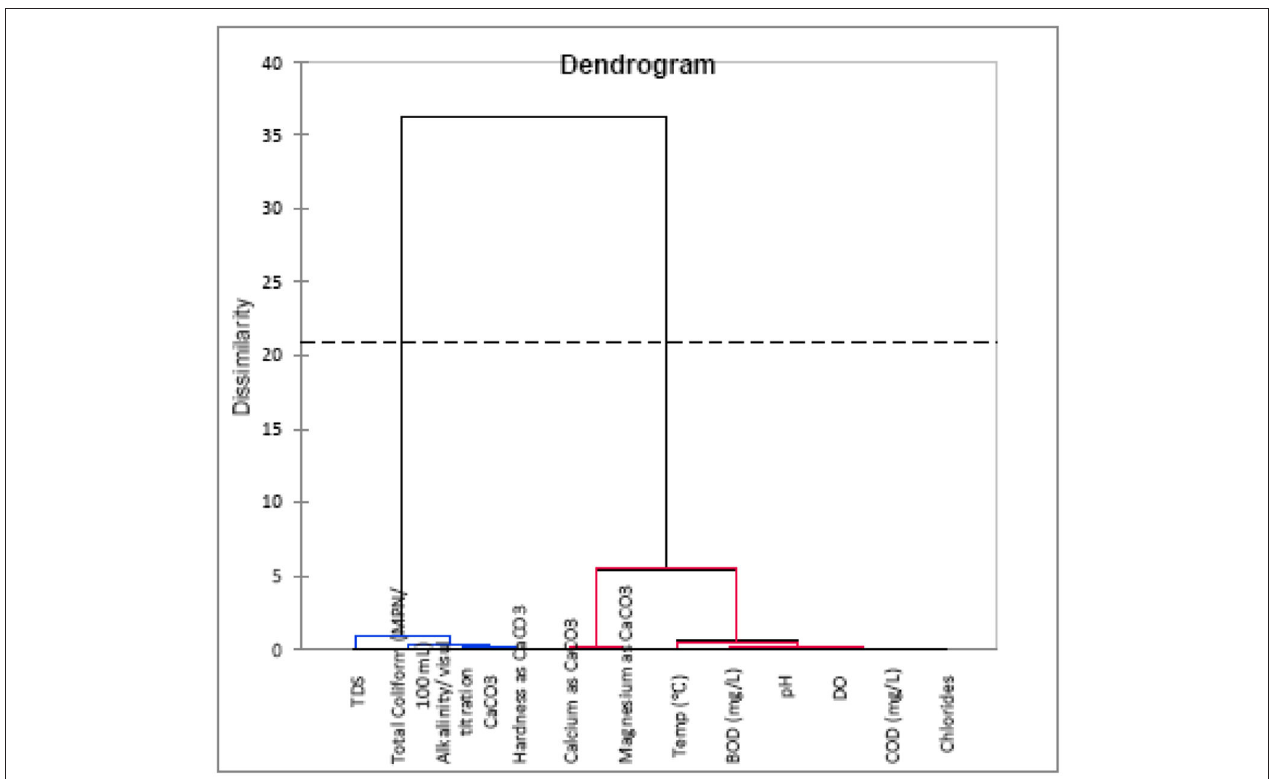
FIGURE 3 | Dendrogram for physicochemical parameters at Dehradun for